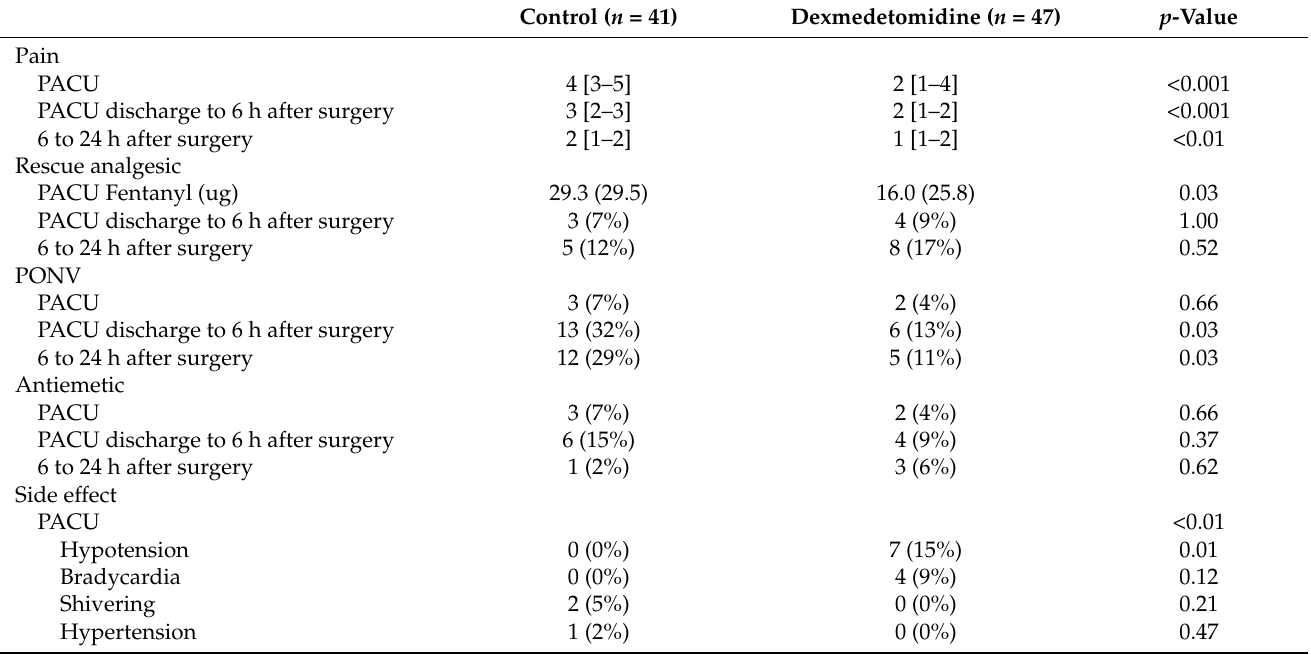
Table 2. Perioperative